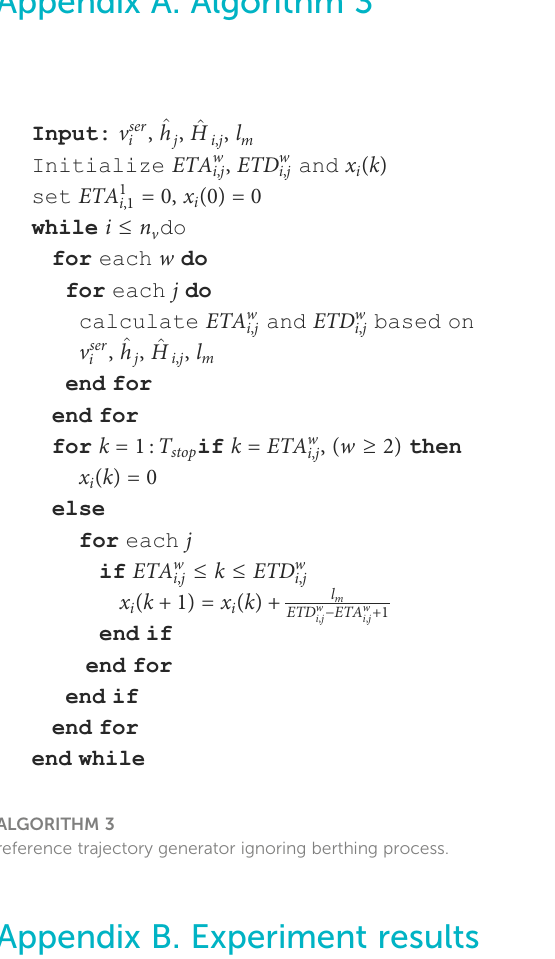
ALGORITHM 3 reference trajectory generator ignoring berthing process.